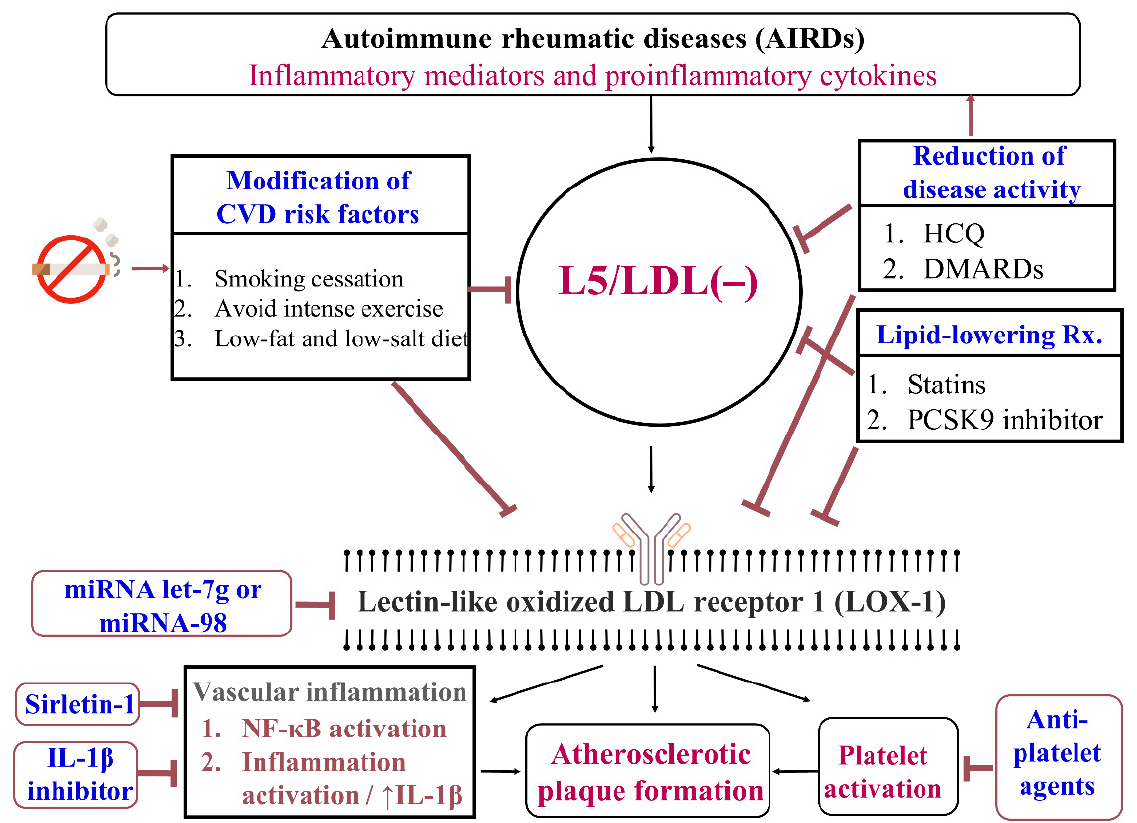
Figure 2. A potential therapeutic strategy for the targeting L5/LDL( − ) and LOX-1 pathway in patients with AIRDs. Major therapeutic strategies include modifications of the traditional CVD risk factors; control of AIRD activity; and the use of lipid-lowering agents, cytokine-targeting agents, and LOX-1-targeting therapy. CVD: cardiovascular disease; LDL: low-density lipoprotein; HCQ: hydroxychloroquine; DMARDs: disease-modifying anti-rheumatic drugs; PCSK9: proprotein convertase subtilisin/kexin type 9; miRNA: microRNA; NF-kB: nuclear factor-kB; IL-1 β : interleukin 1 β .